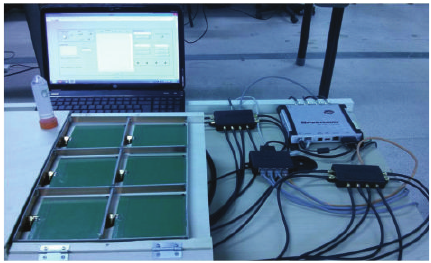
Figure 8: A real photo of the experimental setup. Figure 9: Paths used to evaluate the system capability to intercept simultaneously readings of different